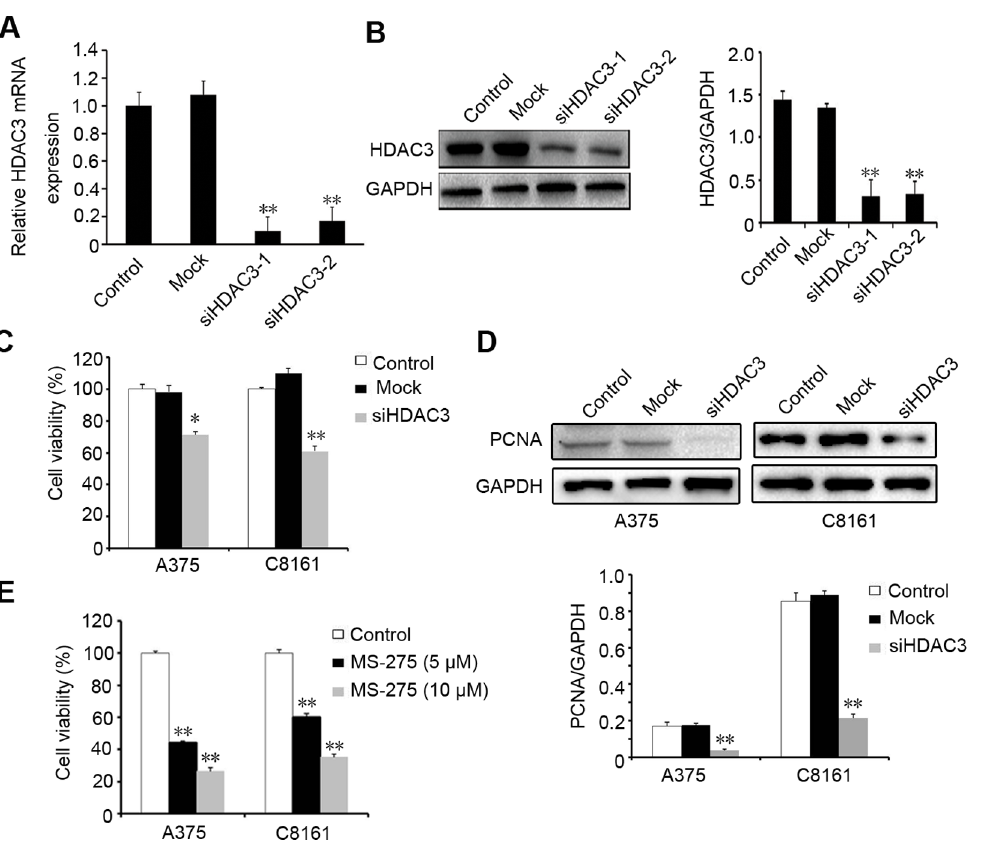
Fig. 4. Down-regulating HDAC3 expression inhibits melanoma cell proliferation. HDAC3 was detected by real-time PCR (A) and Western blotting (B) in A375 cells after tansfection with HDAC3 siRNAs. Cell viability was determined by CCK-8 assay in A375 and C8161 cells (C). PCNA protein expression in A375 and C8161 cells (D). Control: untransfected cells; Mock: cells transfected with vector; siHDAC3: cells transfected with HDAC3-1 or HDAC3-2 siRNA. Cells were exposed to MS-275 (5 m M, 10 m M) for 24 h. Cell viability was determined by CCK-8 assay (E). GAPDH was used as an internal control. The statistical analyses for Western blotting results were shown Data were presented as the mean ¡ S.D. of three independent experiments. *, P , 0.05; **, P ,